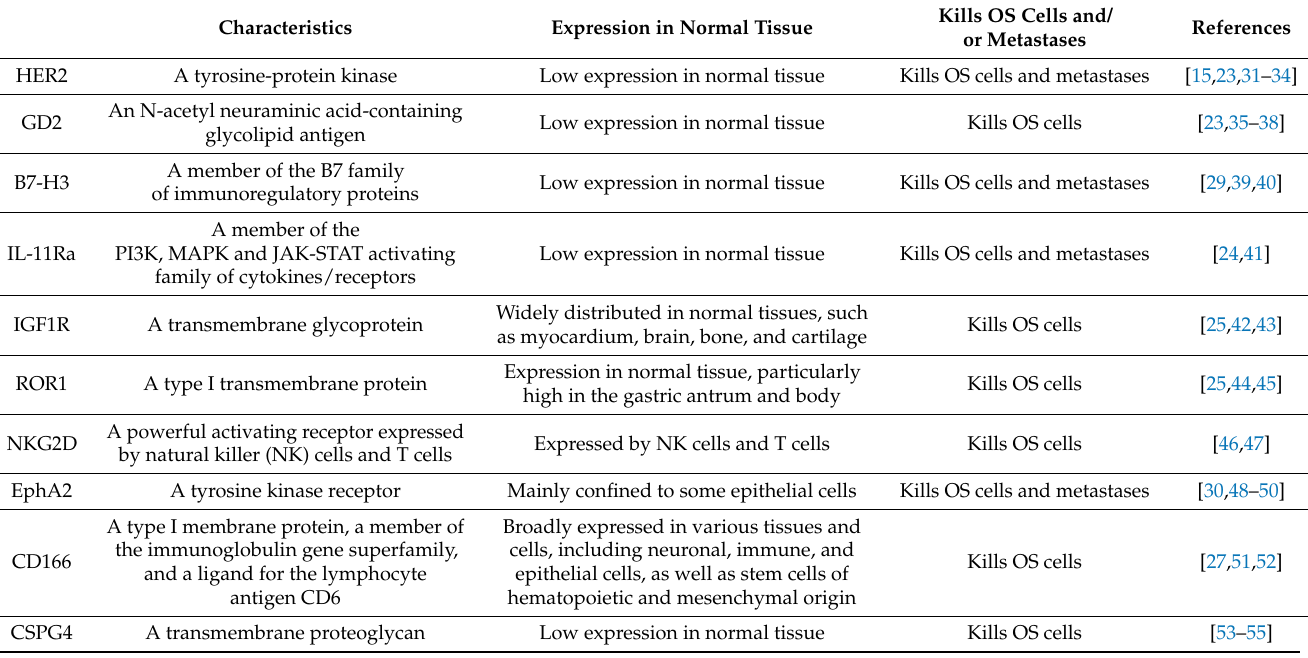
Figure 2. The main targets of CAR-T cells for OS treatment. Table 1. Targets of CAR-T cells in